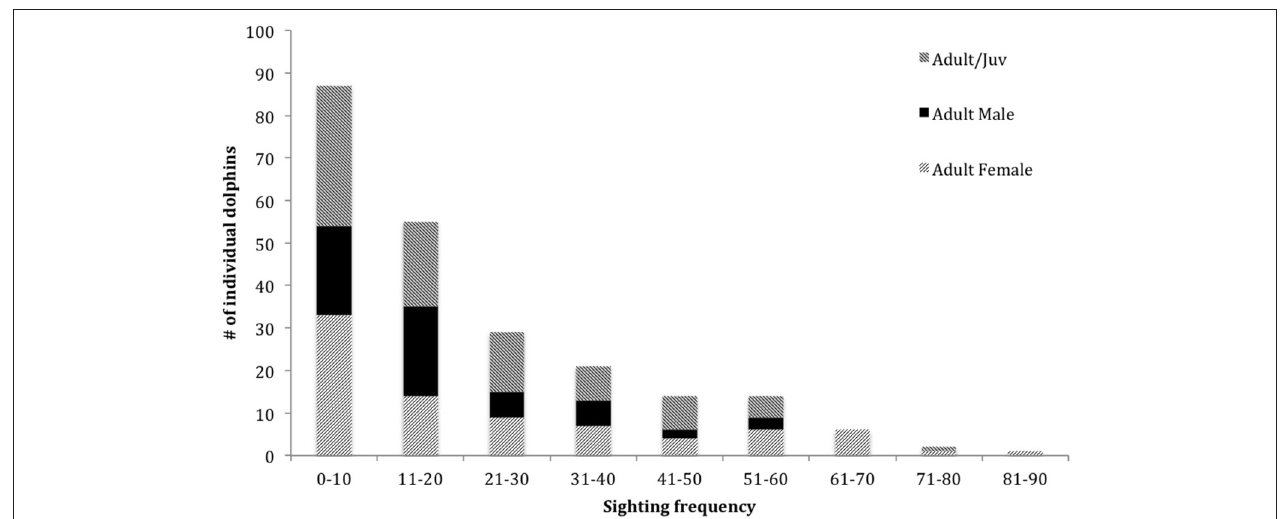
FIGURE 3 | Sighting frequency of dolphins (from excellent and good quality photographs, and highly and moderately distinctive dorsal fins) from March 2007 to April 2013 for adult and juveniles combined ( n = 229, 66 males, 97 females, 66 unknown sex), and adult female and adult male datasets ( n = 81 and 59,